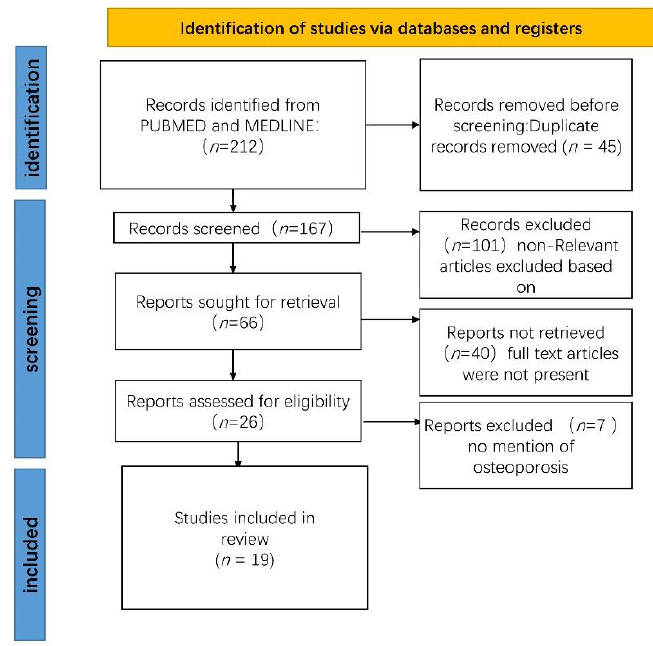
Figure 1. PRISMA flowchart showing the process of study